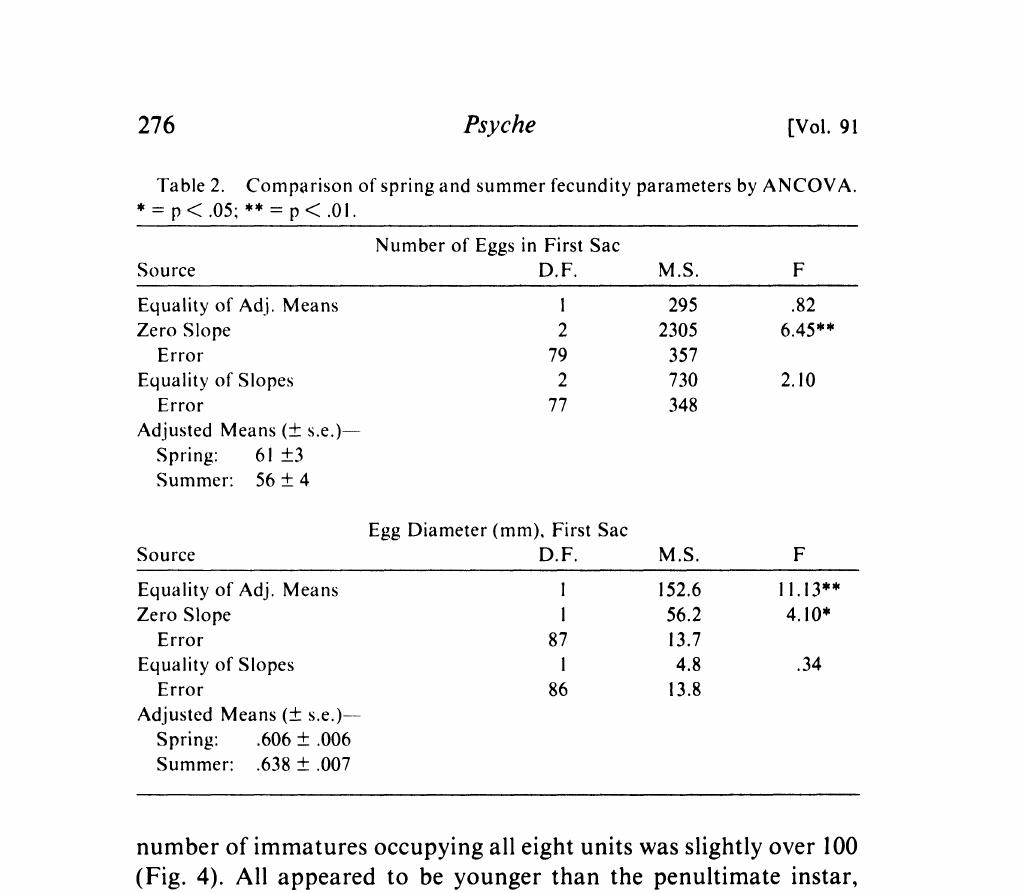
Table 2. Comparison of spring and summer fecundity parameters by ANCOVA. * p < .05; ** p < .01. Number of Eggs in First Sac